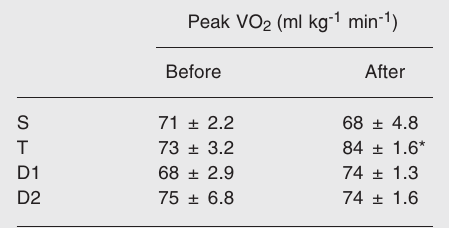
Table 1. Peak oxygen uptake before and after the experimental protocol in rats from the four groups: sedentary (S), trained (T), detrained for 1 week (D1), and detrained for 2 weeks